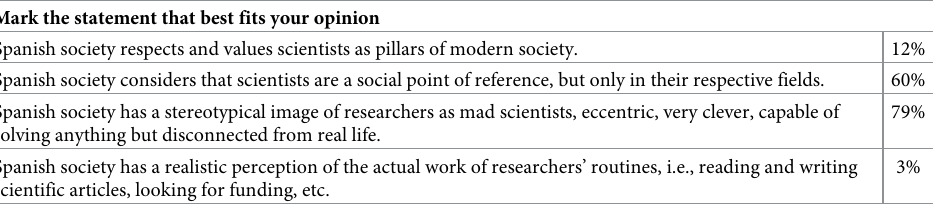
Table 8. Scientists’ views of the public perception of scientists. Mark the statement that best fits your